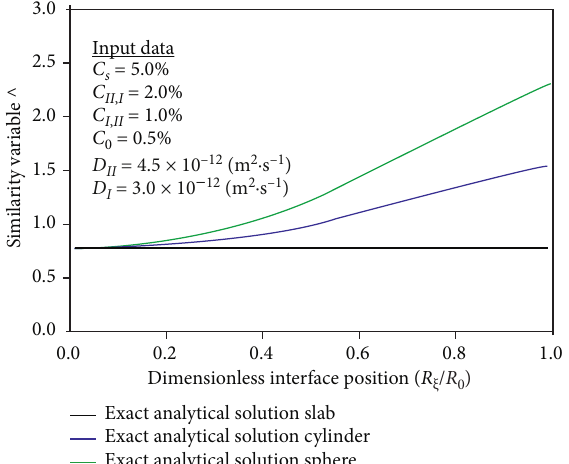
Figure 23: Comparison of similarity variables in relation to the moving interface dimensionless position R slab, a cylinder, and a sphere at 70% of R